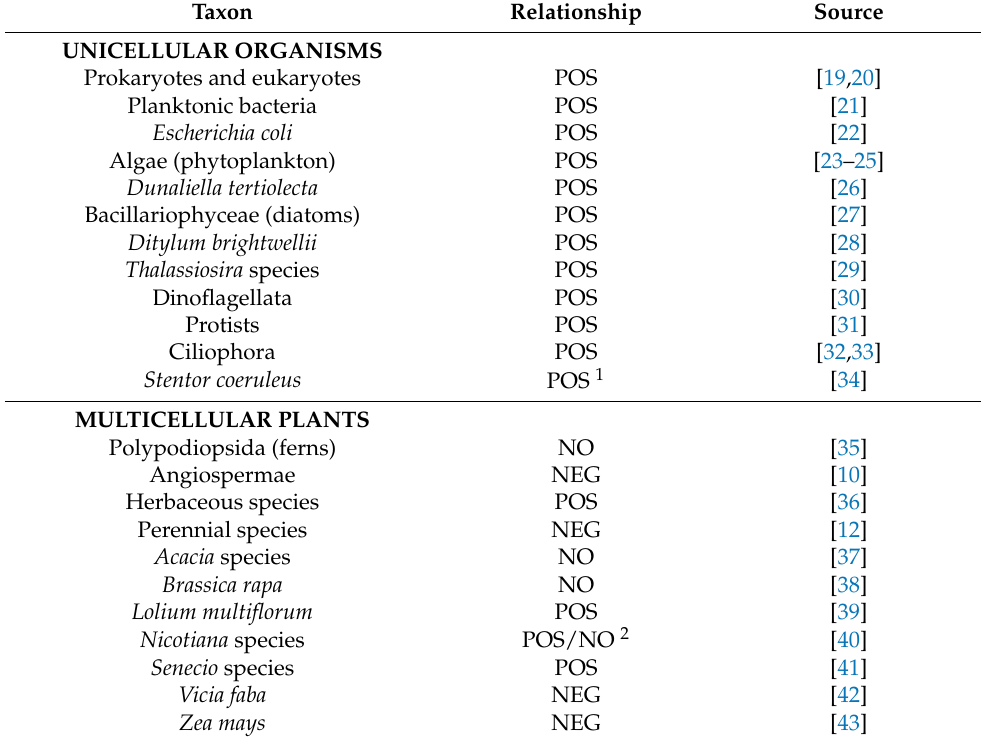
Table 1. Positive (POS), negative (NEG) or nonsignificant (NO) relationships between genome size (total or haploid DNA content per cell nucleus, pg) and body size in various taxa of unicellular and multicellular